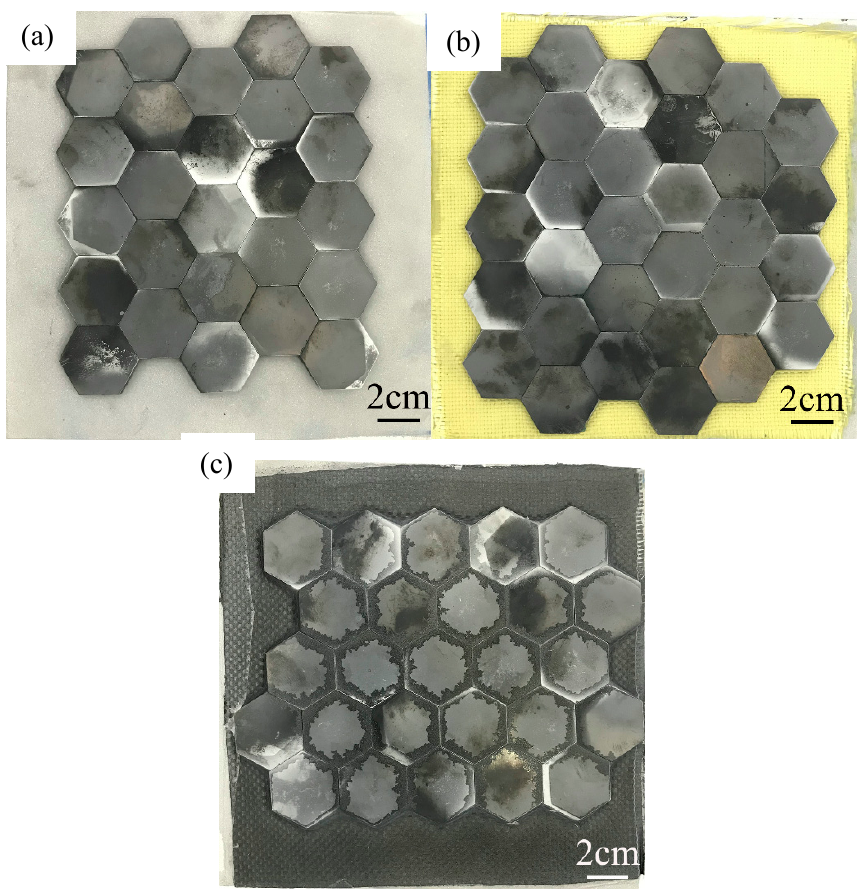
Figure 2. Front view of the three structures: ( a ) Structure 1; ( b ) Structure 2; ( c ) Structure 3.